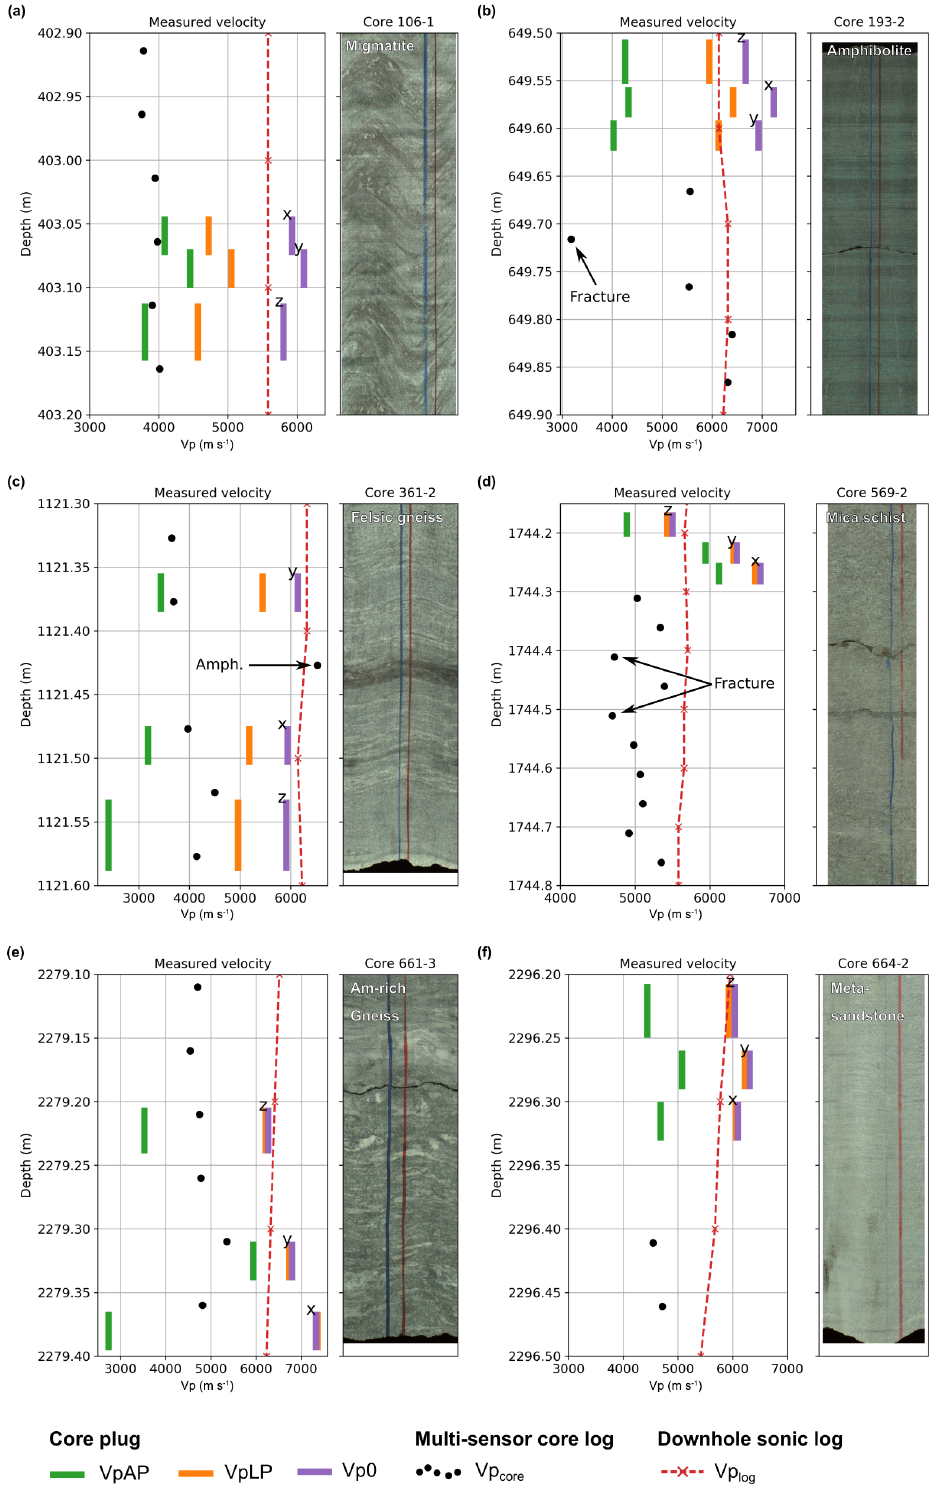
Figure 12. Comparison of P-wave velocities across different scales. (a–f) Laboratory sample, core measurements, and downhole sonic velocities are shown next to the unrolled, true-color core scans. The colored bars represent the location of the three plug locations: black dots – core velocity from MSCL; red dashed line – downhole sonic velocity. The blue and red lines on the core images are common practice to indicate the top and bottom of the